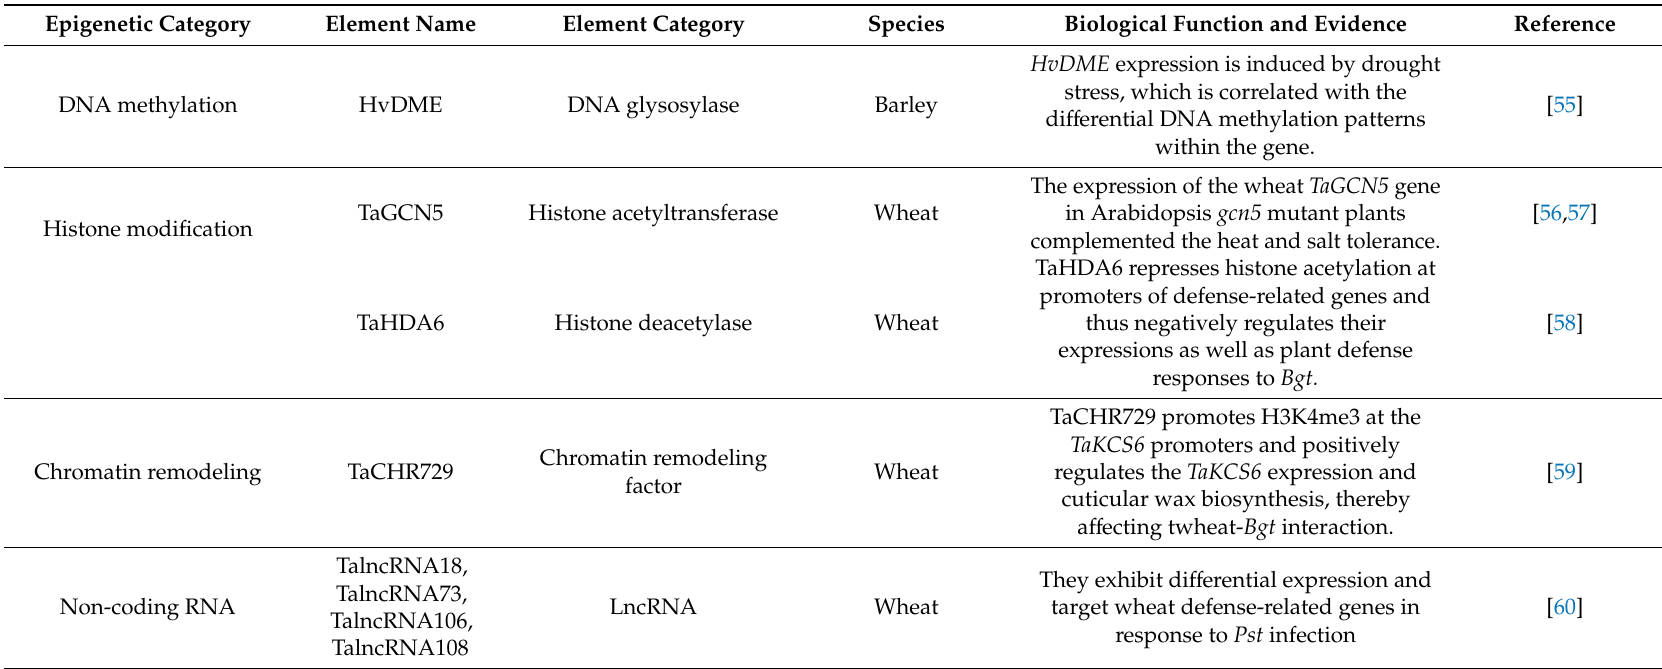
Table 1. The Epigenetics elements involved in stress response in wheat and